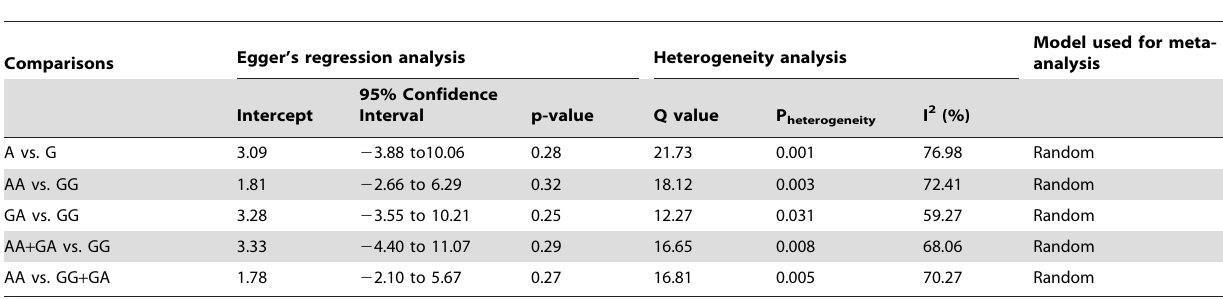
Table 3. Statistics to test publication bias and heterogeneity in the